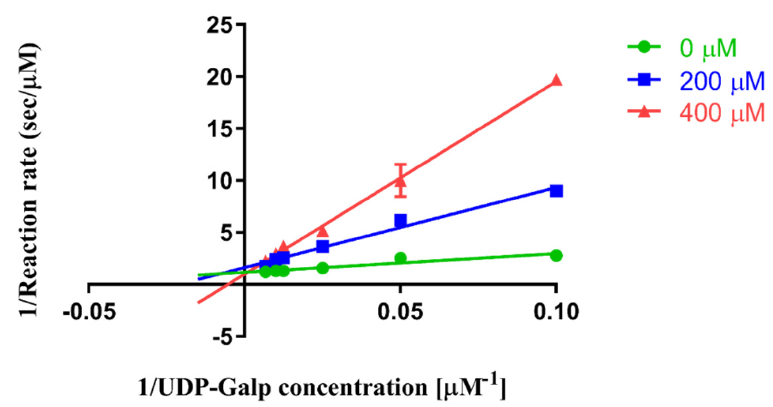
Figure 4. Lineweaver Burk plot of Mtb UGM activity in presence of DA10 at three different concen- trations (0, 200, and 400 µM). In the Dixon plot, the lines intersected above the x -axis in the fourth quadrant, while in the Cornish-Bowden plot the lines were parallel. These plot patterns are characteristic of com- petitive inhibition (Figure 5).